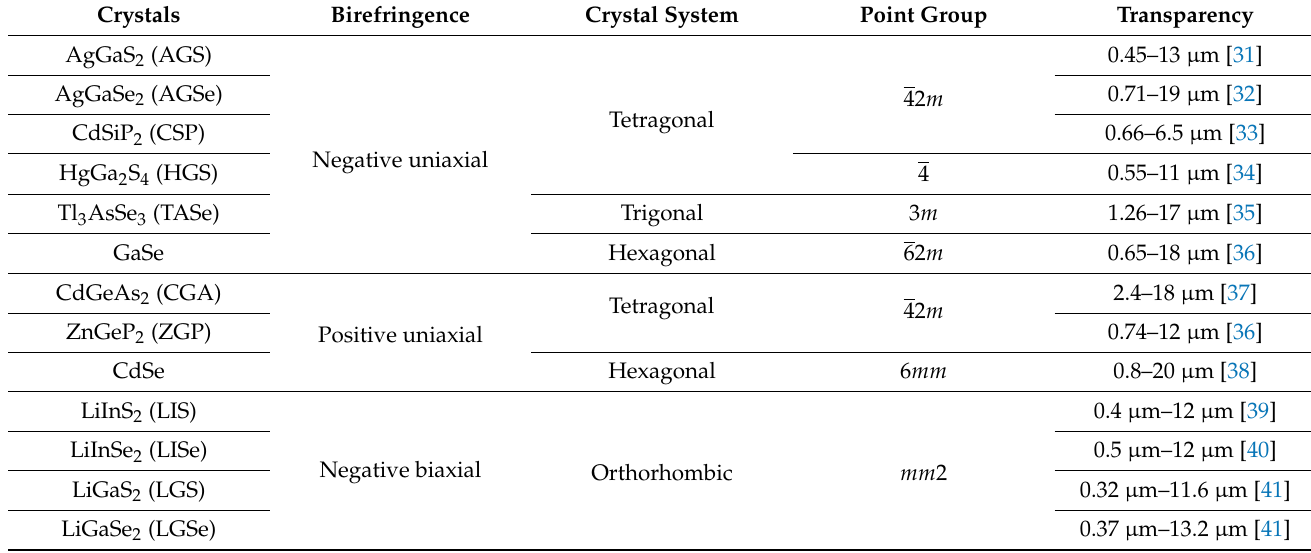
Table 1. Non-oxide nonlinear optic (NLO) crystals considered for broadband mid-IR second-harmonic generation (SHG). Crystals Birefringence Crystal System Point Group Transparency AgGaS 2 (AGS)